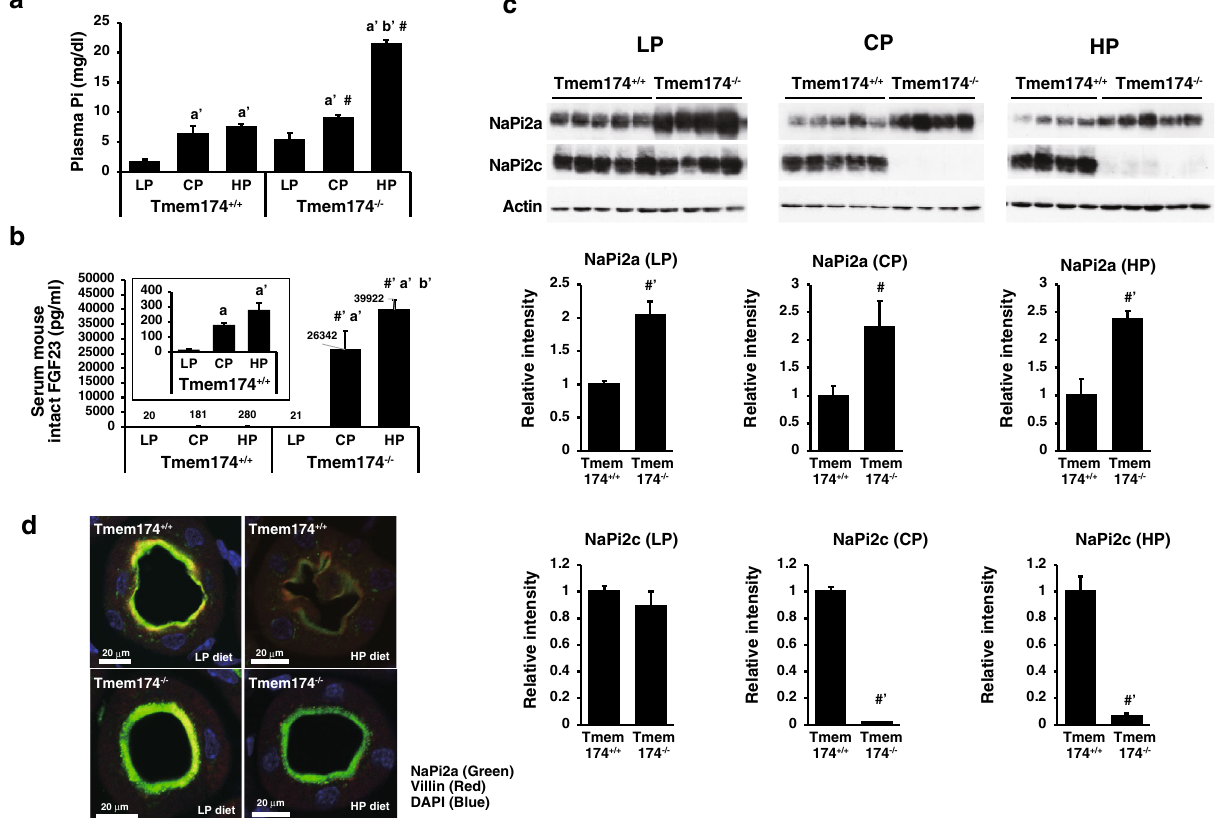
Figure 8. Dietary Pi regulation in Tmem174 −/− mice. Male Tmem174 +/+ and Tmem174 −/− mice (n = 5) fed a low Pi (LP: 0.02%), control Pi (CP: 0.6%), or high Pi (HP: 1.2%) diet for 12 days. ( a ) Plasma Pi, ( b ) Serum intact FGF23, Values are mean ± SE. # p < 0.05, #’ p < 0.01 vs same diet, a p < 0.05, a’ p < 0.01 vs LP, b’ p < 0.01 vs. CP of same genotype. ( c ) Western blotting analyses. Each lane was loaded with 20 μg of BBMVs. Actin was used as an internal control. Values are mean ± SE. # p < 0.05, #’ p < 0.01. ( d ) Immunostaining of renal NaPi2a (Green) localization in the kidney sections of mice fed the LP (0.02% Pi) and HP (1.2% Pi) diet for 7 days. DAPI (Blue), Villin (Red). Experiments were performed in